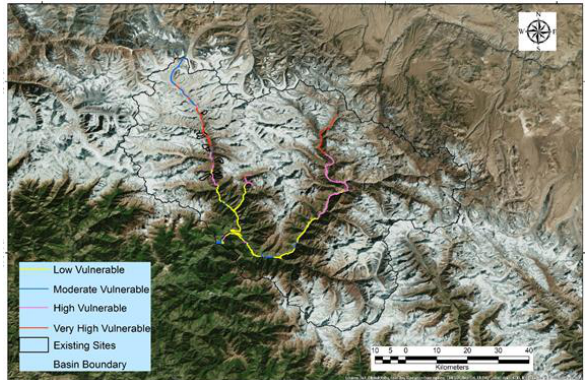
Figure 9 Avalanche susceptibility of road network in Alaknanda